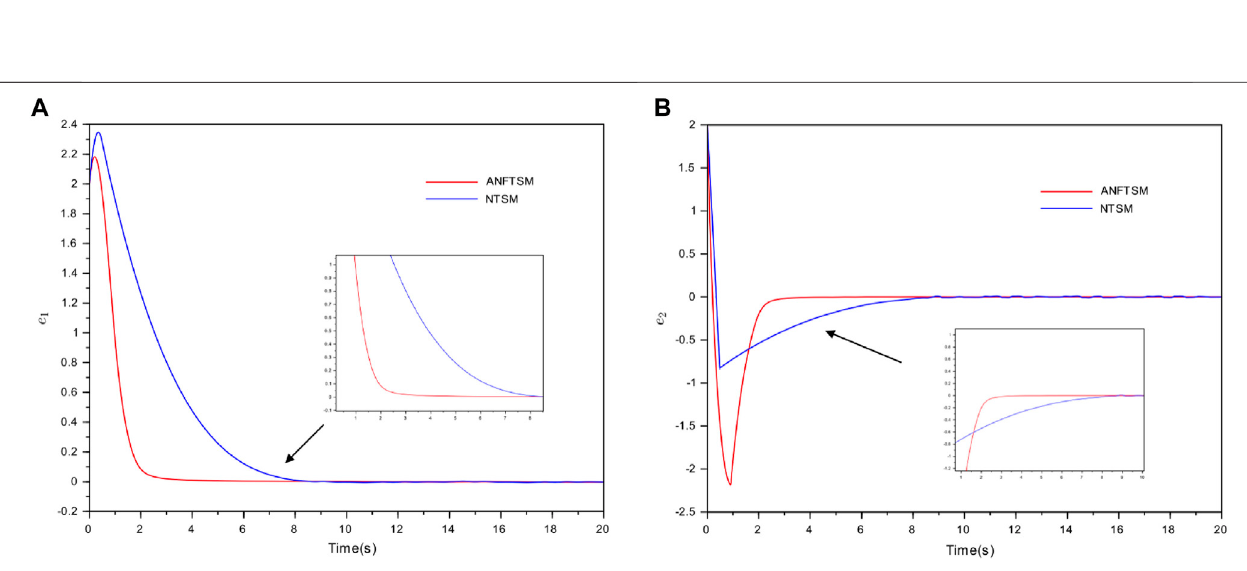
Frontiers in Applied Mathematics and Statistics |